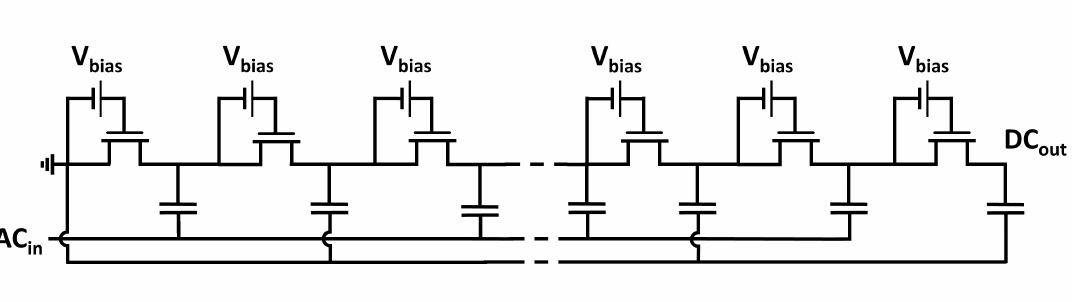
Figure 5. Circuit schematic of a threshold-compensation technique with ideal dc bias